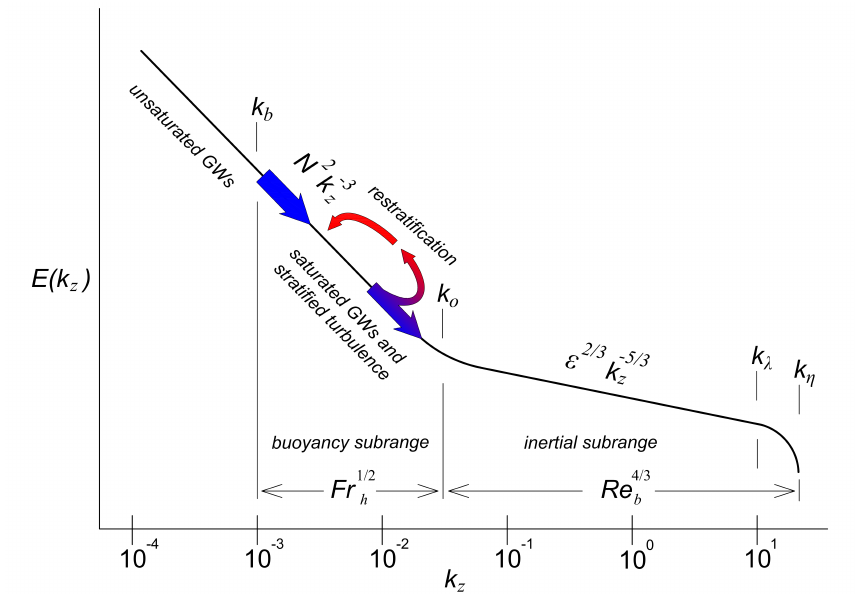
Figure 1. Schematics of vertical wavenumber spectra of turbulent energy. k b is the buoyancy scale (4); k o is the Ozmidov scale (1); k λ is the Taylor microscale (5) and k η is the Kolmogorov scale. The blue arrows show the constant spectral energy flux and red arrows highlight the region in the buoyancy subrange, where buoyancy flux re-stratifies the flow through partial conversion of potential into kinetic